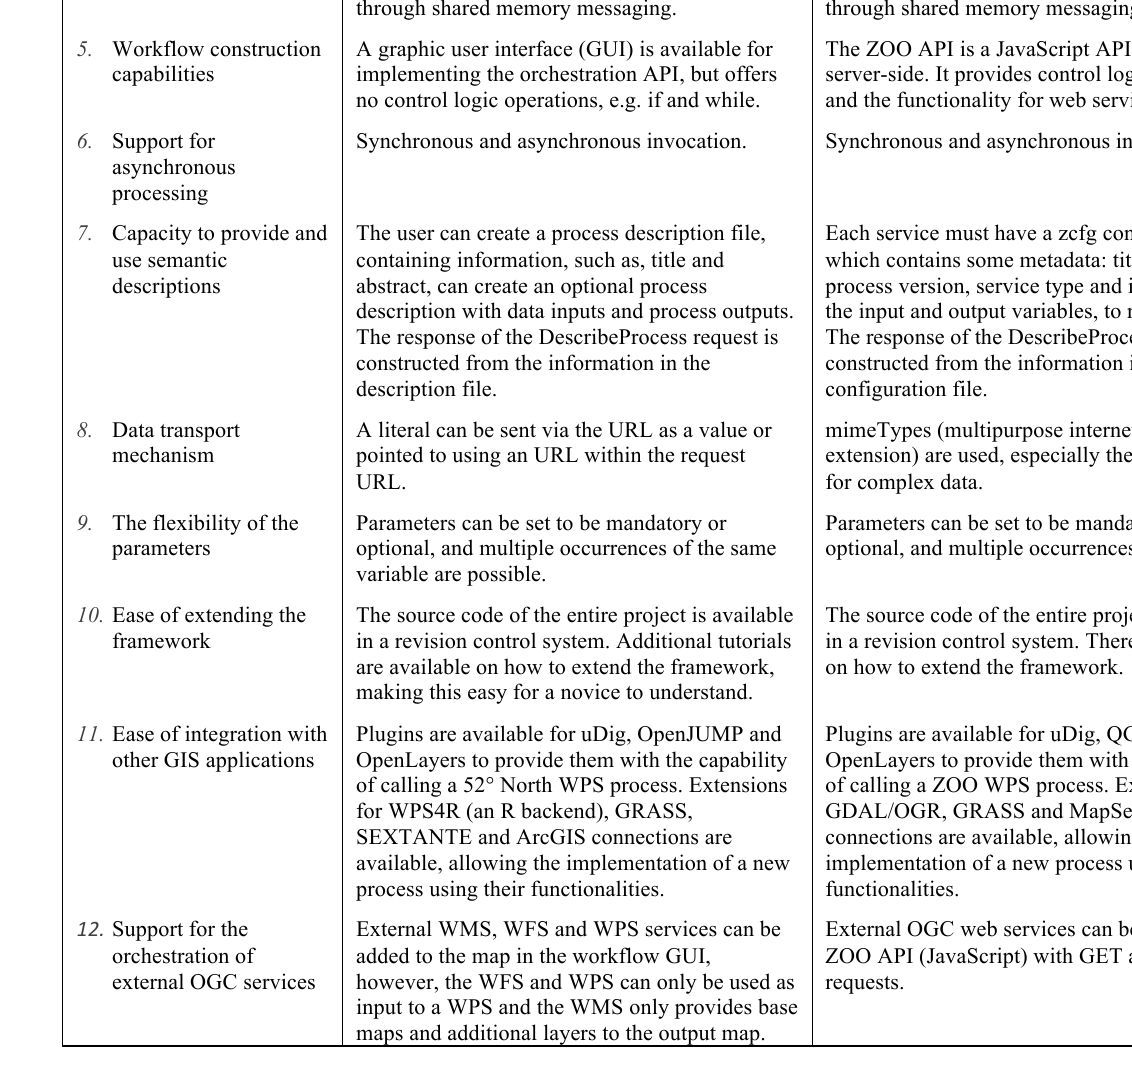
Table 1. Comparison of 52° North and ZOO Project framework according to the criteria